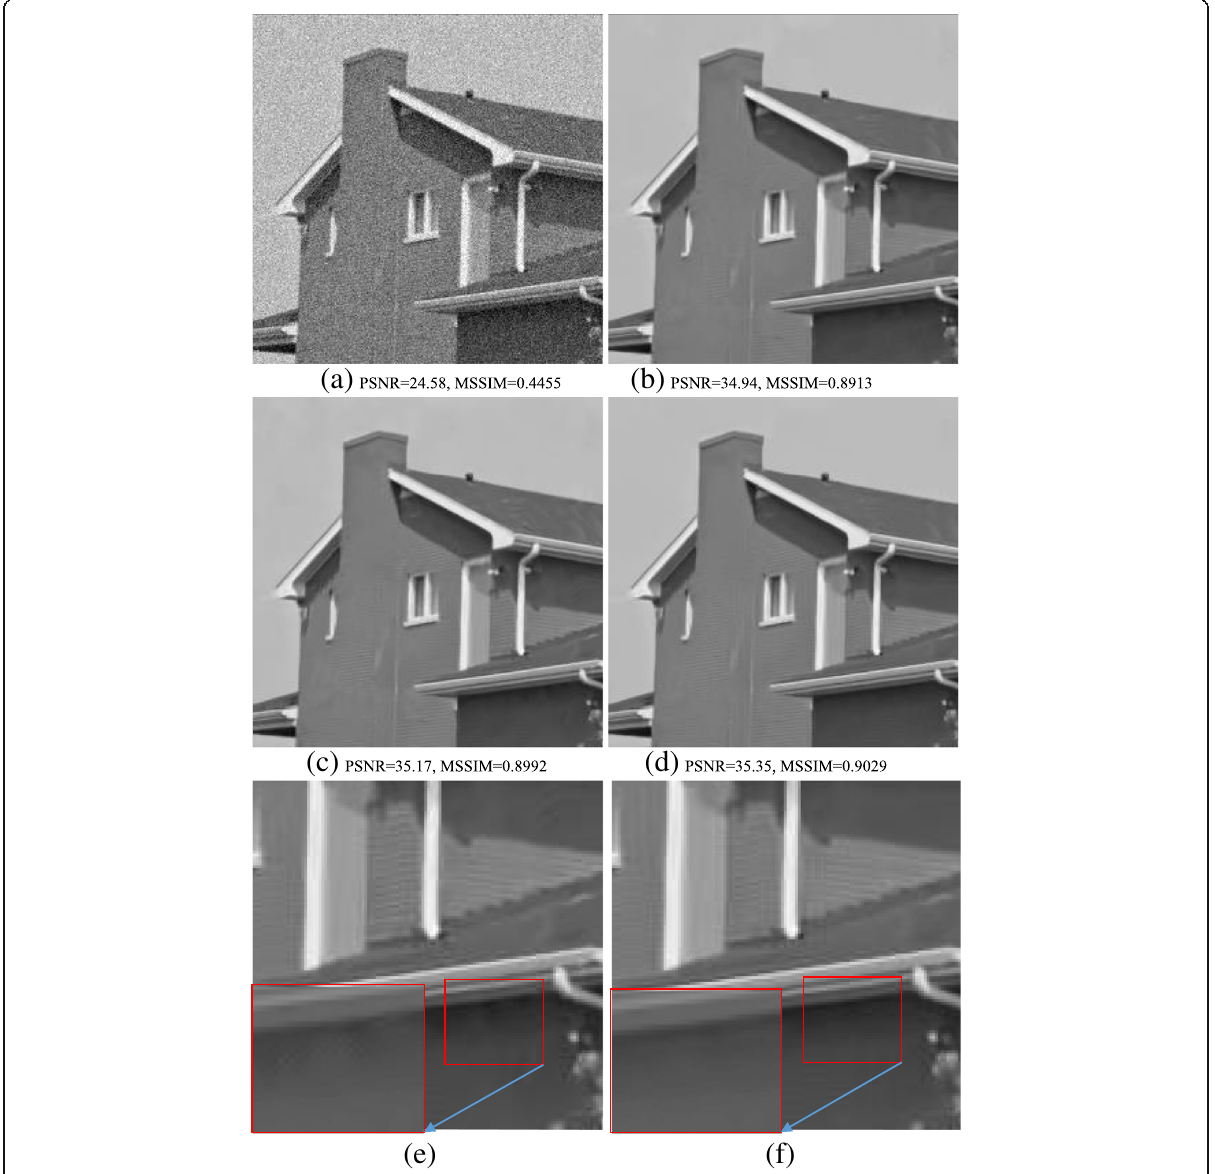
Fig. 7 Comparison of denoised results by BM3D, BM3D-SAPCA, and SA-BM1-3D. a Noisy image ( σ = 15), b BM3D, c BM3D-SAPCA, d SA-BM1-3D, e zoomed patch of ( c ), and f zoomed patch of ( d